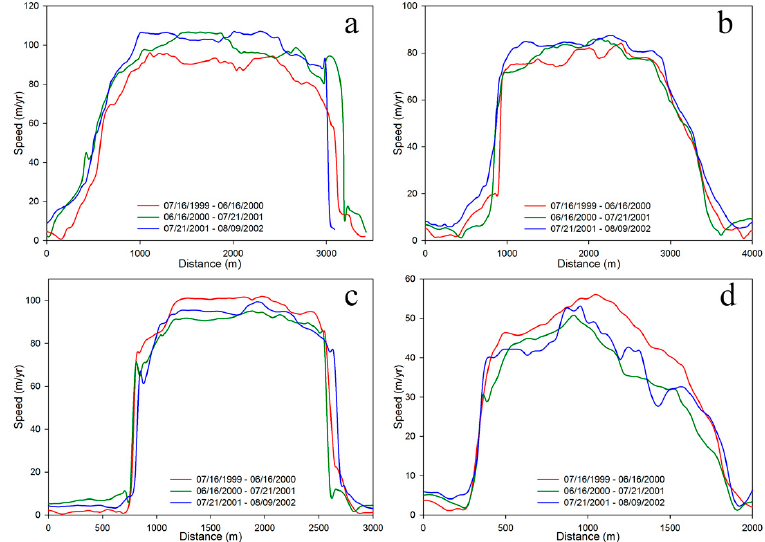
Figure 12. Transverse speed profiles of the Siachen Glacier. Profile locations are depicted in Figure 5a. ( a – d ) The comparison of annual surface velocity change along the transverse profile T1, T2, T3, and T4, respectively.